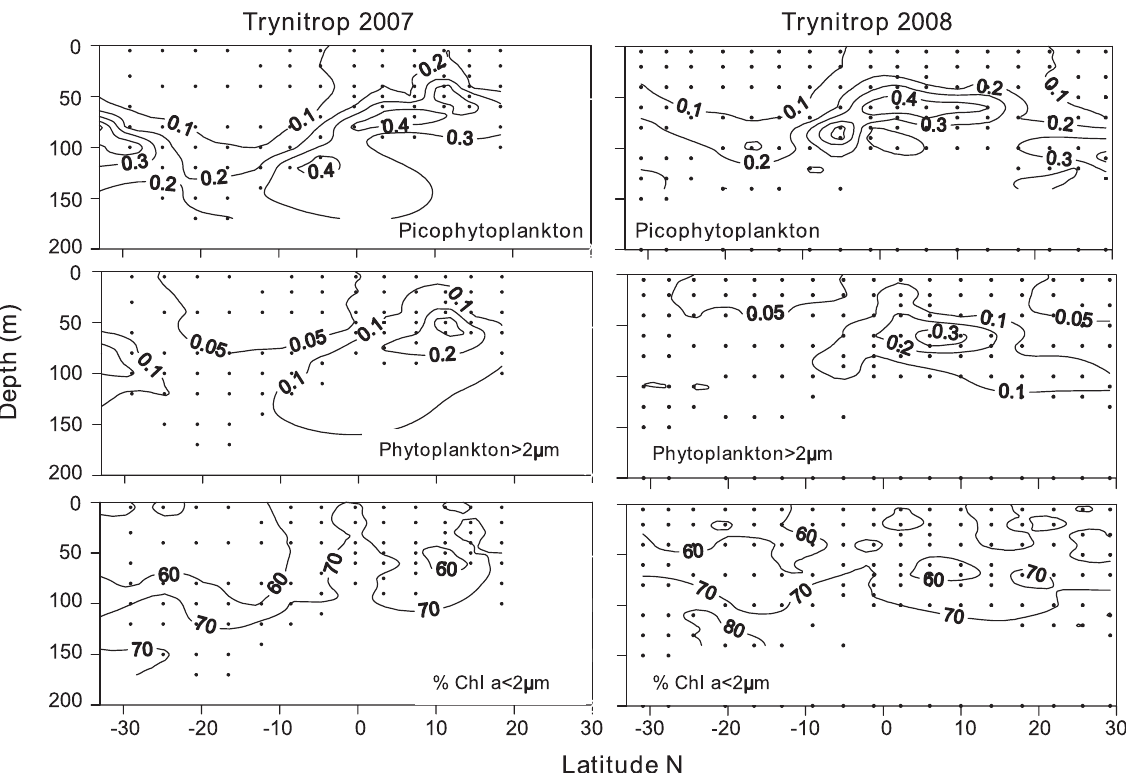
Fig . 3. – Latitudinal distribution of size-fractionated chl a (mg m -3 ) and contribution of picophytoplankton to total chl a (%). Left panel, Trynitrop 2007; right panel, Trynitrop 2008.